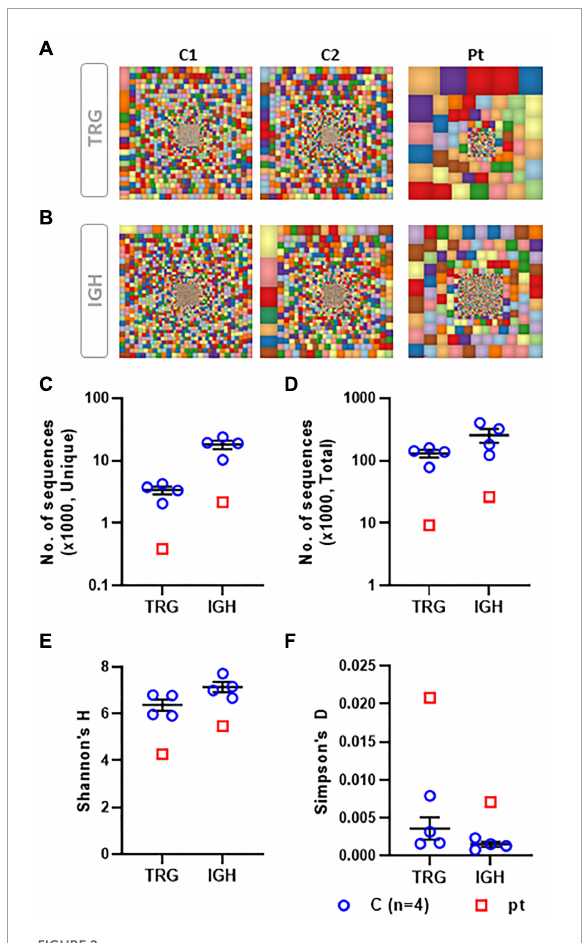
FIGURE2 Characteristics of the TRG and IGH repertoire determined by NGS. Graphical presentation of the TCR gamma (TRG) repertoire using the Tree map program where each square represents a specific clone and the size of the square represent the frequency of the clone, for TRG (A) and IGH (B) repertoires. A scatter dot plot presenting the unique (C) and total (D) number of sequences for TRG and IGH repertoires. A scatter dot plot presenting the Shannon’s H diversity index (E) and the Simpson’s Index of Unevenness (F) for TRG and IGH repertoires. TRG and IGH repertoire analysis from a total of four controls were compared with our patient’s